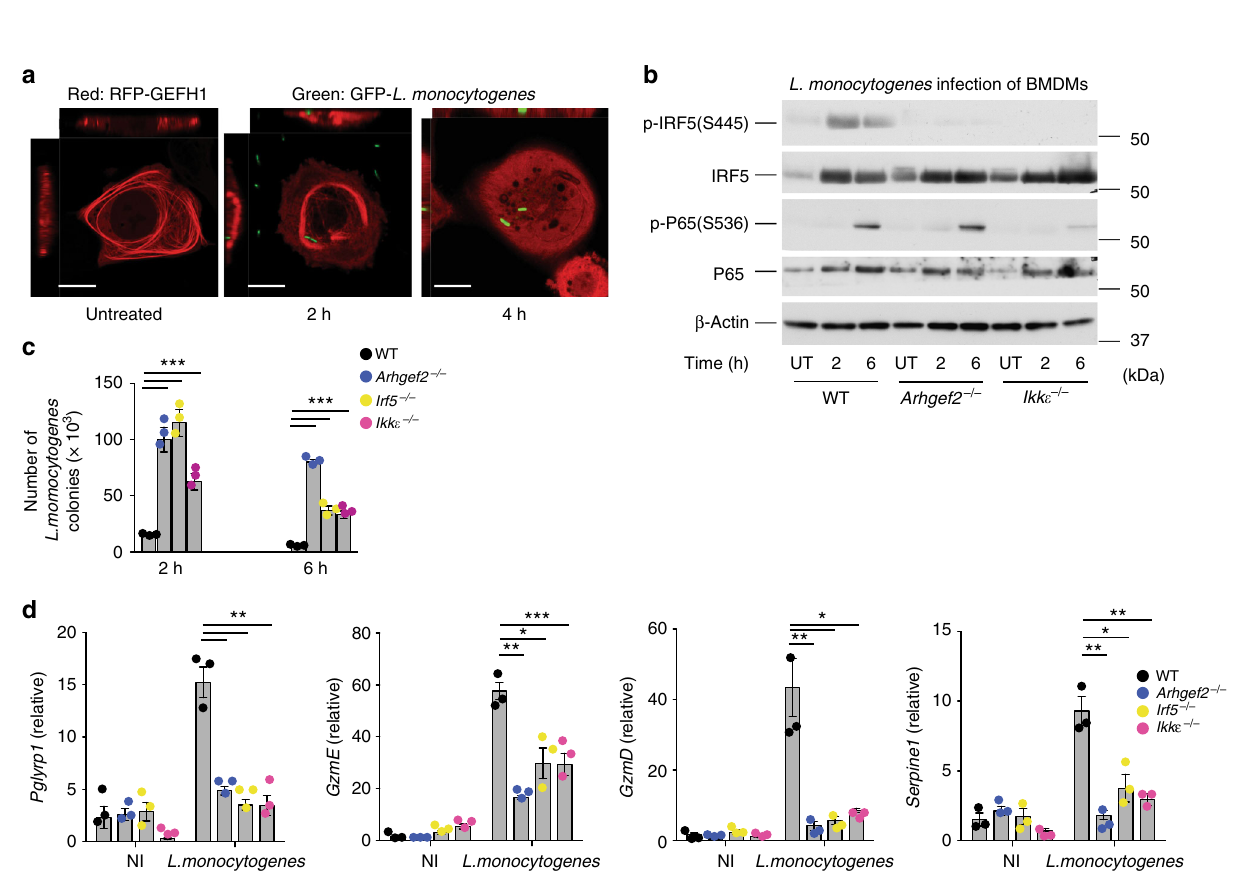
Fig. 6 GEF-H1-IRF5 signaling controls host defense against L. monocytogenes . a Confocal microscopic analysis of subcellular localization of GEF-H1 in ARPE- 19 before and during infection with L. monocytogenes . Scale bars, 10 µ m. b Immunoblot analysis of N -glycolyl-MDP induced IRF5 and p65 phosphorylation in BMDMs isolated from WT, Arhgef2 − / − and Ikk ε − / − mice. c Gentamycin protection assay for the assessment of intracellular L. monocytogenes in BMDMs isolated from WT (black square), Arhgef2 − / − (blue square), Irf5 − / − (yellow square), and Ikk ε − / − mice. d Gene expression analysis by qRT-PCR of Pglyrp1 , GzmE , GzmD , and Serpine1 in BMDMs derived from WT (black square), Arhgef2 − / − (blue square), Irf5 − / − (yellow square), and Ikk ε − / − mice infected with L. monocytogenes or non-infected (NI). Error bars indicate mean±SEM. Statistical signi fi cance was calculated using Student ’ s two-tailed t test ** P < 0.001 *** P < 0.0001 ( n = 3). Source data are provided as a Source Data fi